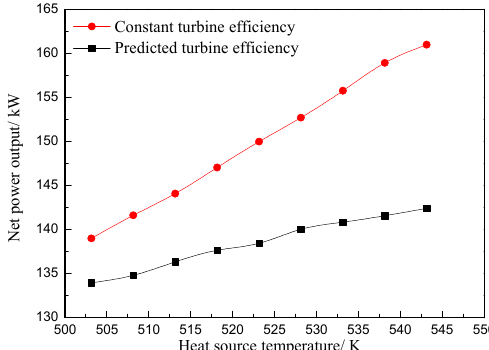
Figure 13. Turbine efficiency at different heat source temperature.